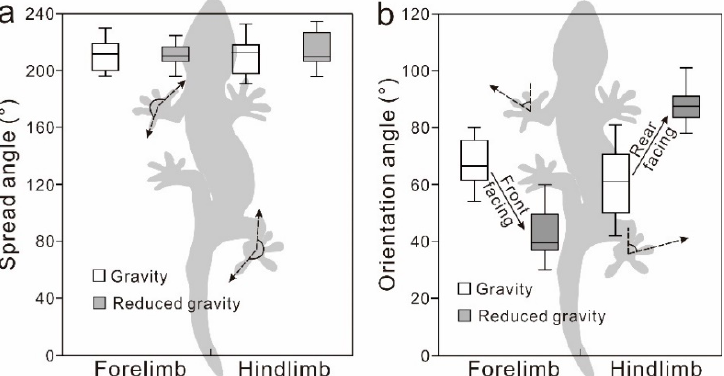
Figure 3. ( a ) The spread angle of the forelimb and hindlimb in the gravity condition and in the reduced gravity condition. ( b) The orientation angle of the forelimb and hindlimb in the gravity condition and in the reduced gravity condition.